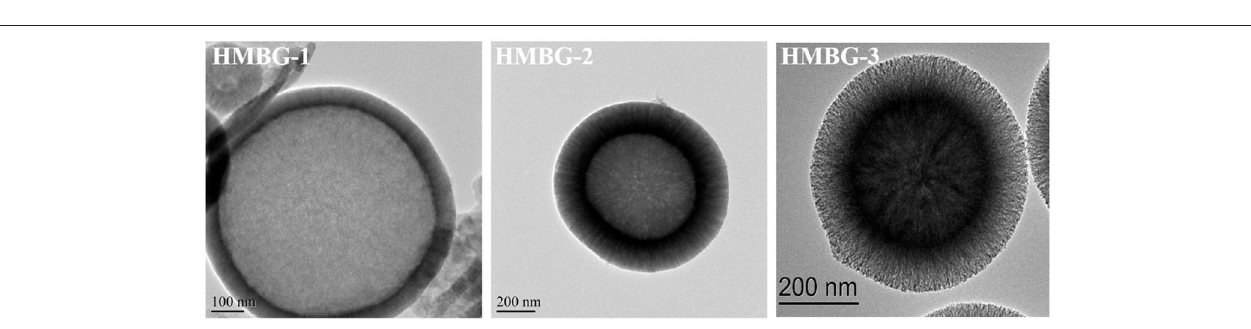
FIGURE 4 | The TEM images of HMBG nanoparticles.